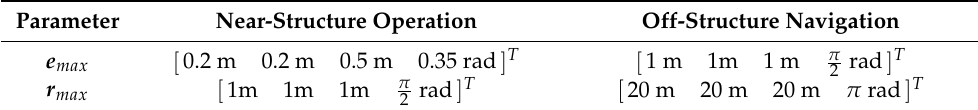
Table 2. Control performance parameters for operations.